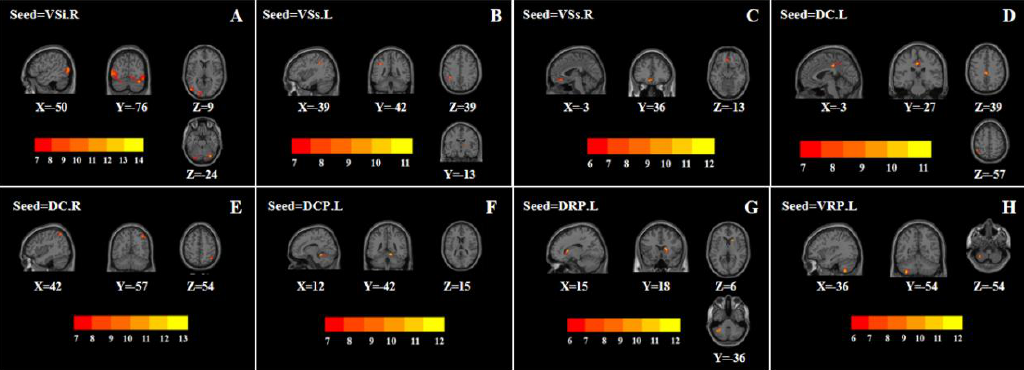
MNI Peak, Coordinates of primary peak locations in the Montreal Neurological Institute space.